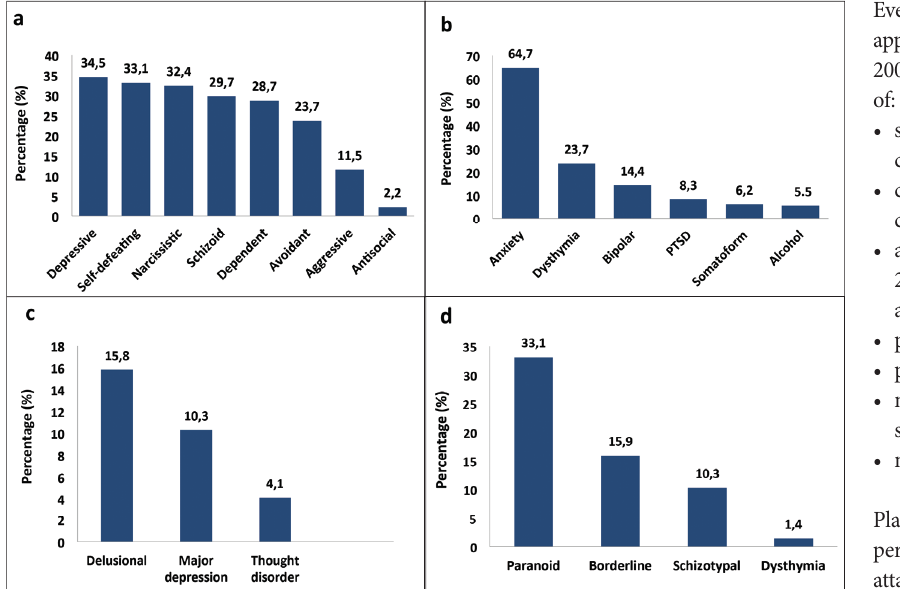
Fig. 2. MCM-III – distribution of (a) clinical patterns, (b) clinical syndromes, (c) severe syndromes, and (d) severe pathology.